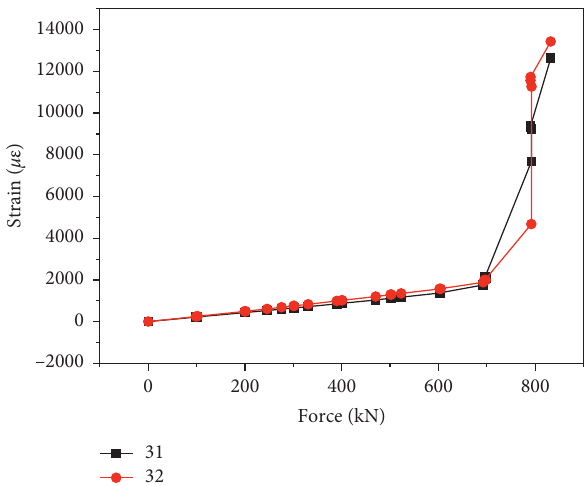
Figure 23: Load-strain curves of bottom steel plates of SC-P3.